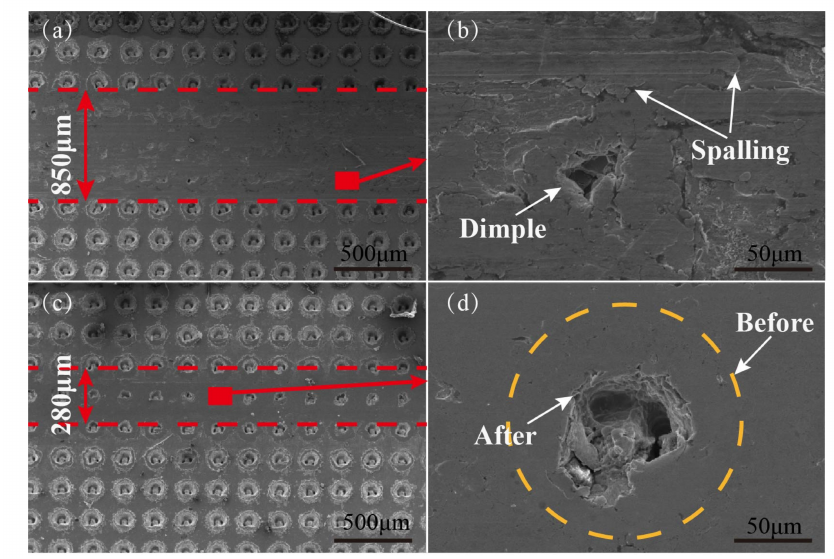
Figure 10. SEM images of the worn plates (3#, 100 ◦ C): ( a , b ) PAO4; and ( c , d ) PAO4 +